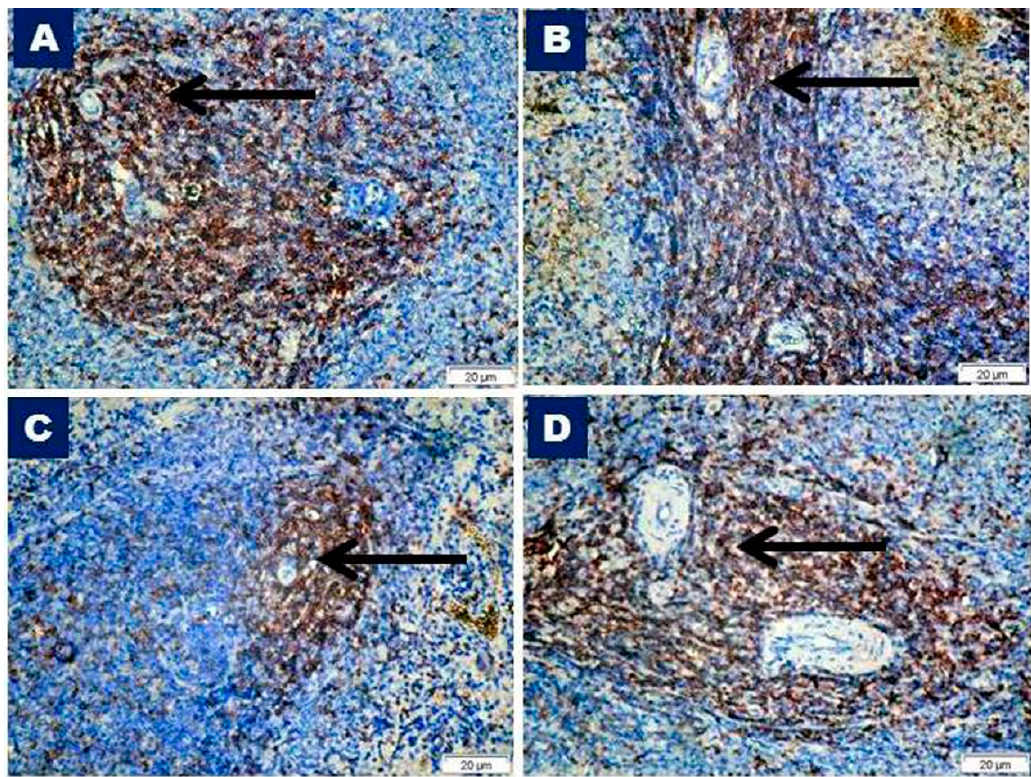
Figure 5. Photomicrographs of immunohistochemically-stained sections of the spleen with anti-cluster of differentiation 3 (CD3) from different studied groups. ( A ) Control group (I), ( B ) Vitamin C group (II) showing strong positive T-lymphocytes in periarteriolar areas (arrows ). ( C ) Olanzapine treated group (III) showing a decreased CD3 positive reaction in the periarterial lymphatic sheath (arrow). ( D ) Vitamin C and Olanzapine treated group (IV) showing an increased CD3 positive reaction in the periarteriolar areas (arrow). CD3, ×400